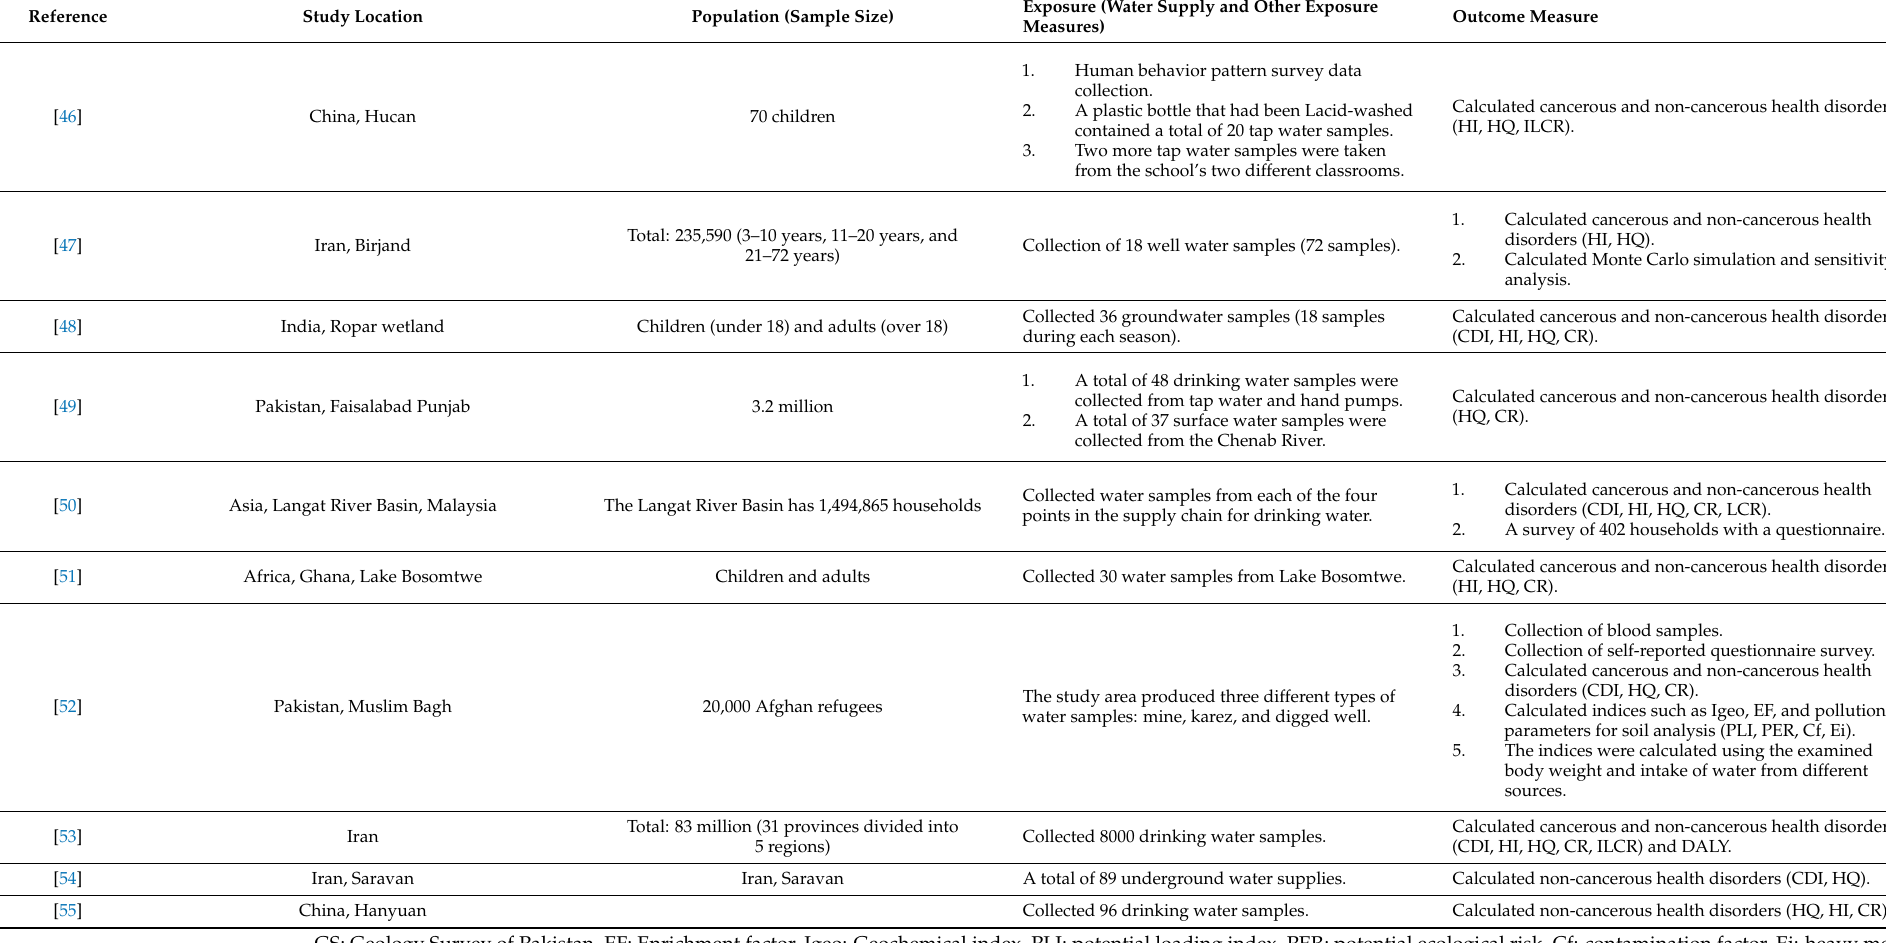
Table 5. Main characteristics of the selected case studies included in the systematic